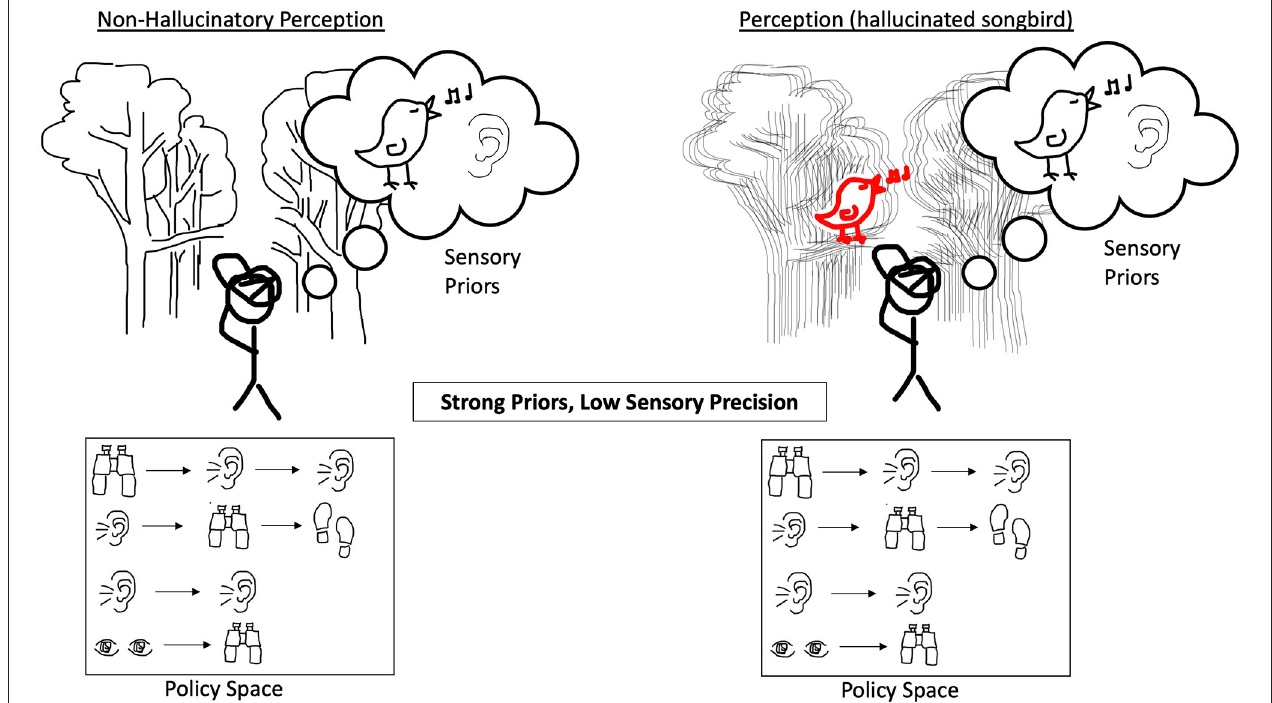
FIGURE 1 | The perception of an agent that does not hallucinate is shown on the left. The incoming sensory evidence about the environment has a normal confidence ascribed to it and the agent has an expansive policy space without bias toward a specific string of actions. The agent does, however, have a strong prior belief that it will perceive a singing bird. On the right, when precision of incoming sensory evidence is reduced and the forest scene looks blurry, the agent is unable to use the environment to correct for their strong prior belief and hallucinates the singing bird.